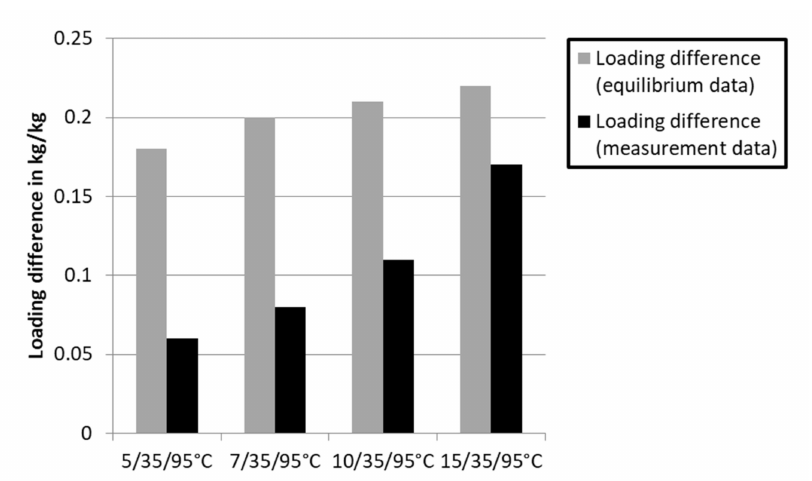
Figure 12. Loading difference calculated with the measured data compared to the loading difference that can be expected if sorption equilibrium is reached at the end of the adsorption and desorption half cycle. The loading differences are evaluated for the four different temperature conditions studied in this